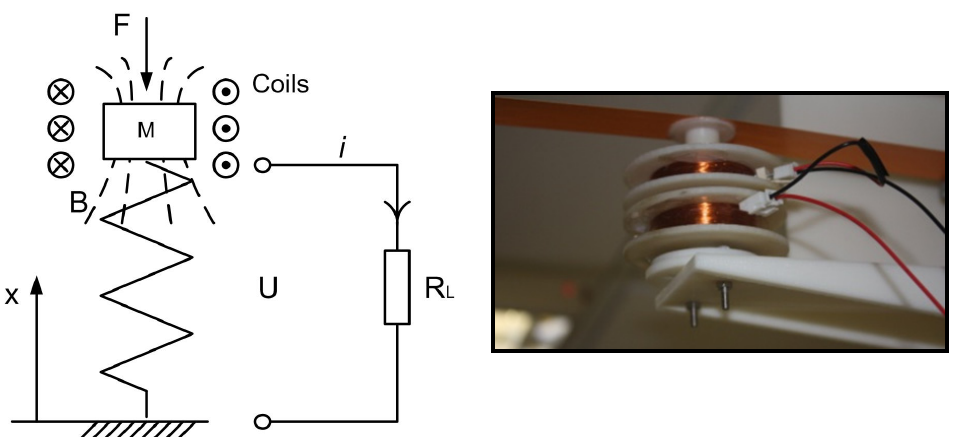
Figure 8. Schematic of a linear fixed-coil electromagnetic